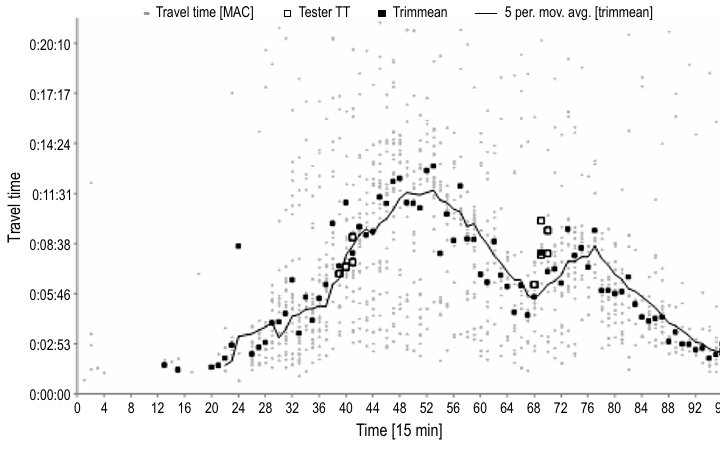
Fig. 12. Measured vs estimated travel Table. Indicators for the validation of travel time estimation Indicator